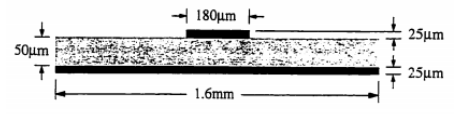
Fig. 5. Conductor over a ground plane.